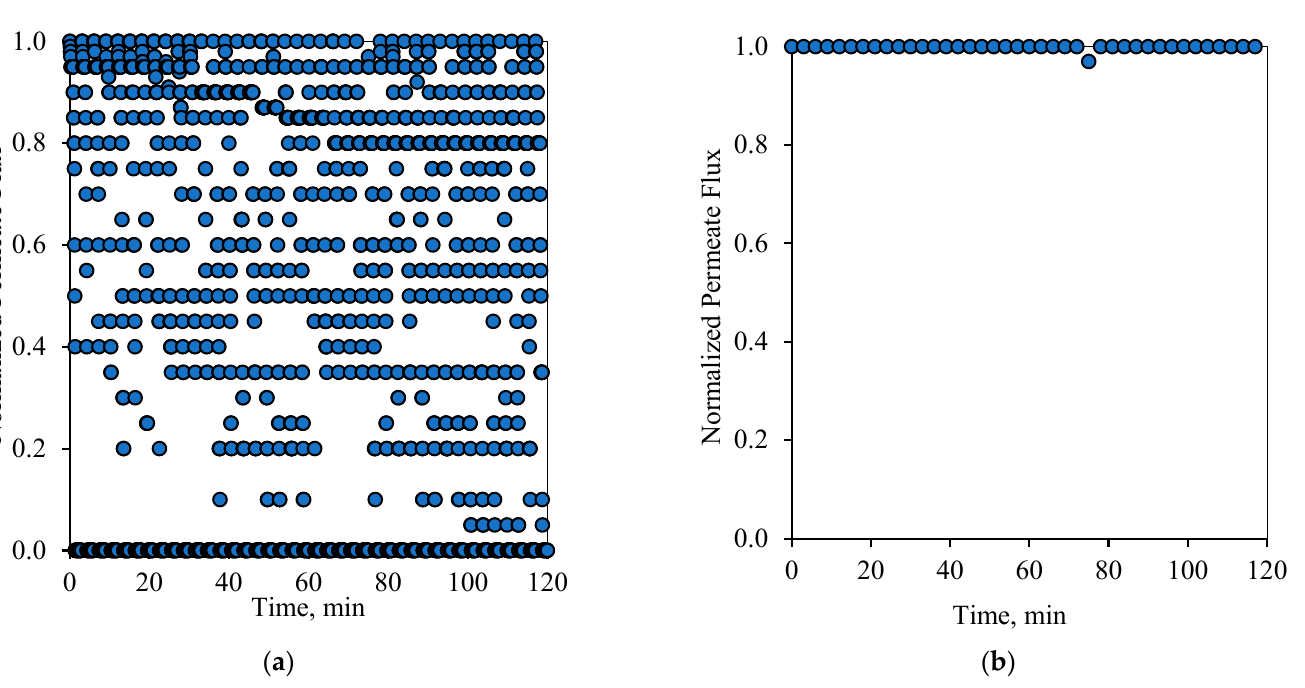
Figure 8. Permeate flux profile using the 1-2 PFPT for a feed of 100 ppm at CFV: 1 m/s: ( a ) 2 h of filtration operation, ( b ) membrane permeability after each cleaning